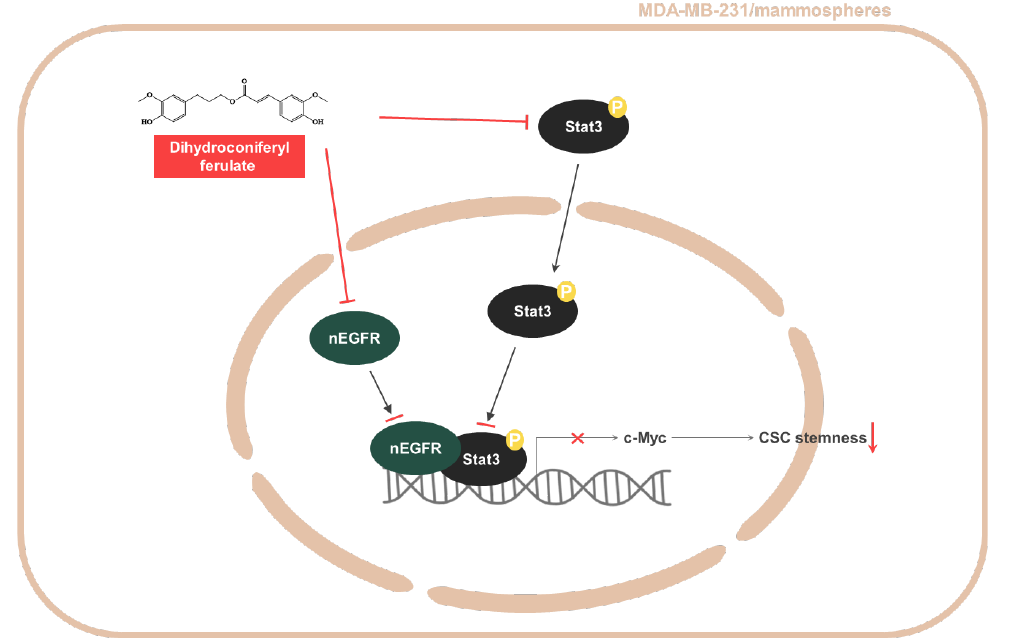
Figure 8. Schematic summary of breast CSC formation via the Stat3/nEGFR/c-Myc signaling pathway induced by dihydroconiferyl ferulate .